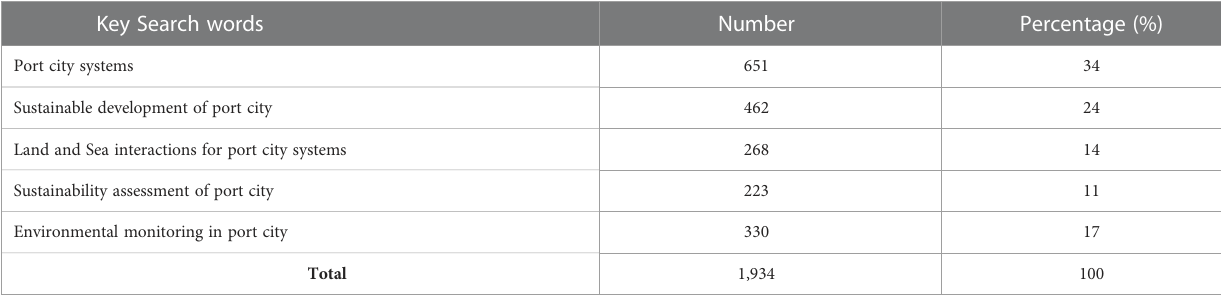
TABLE 5 Results of corresponding search words.